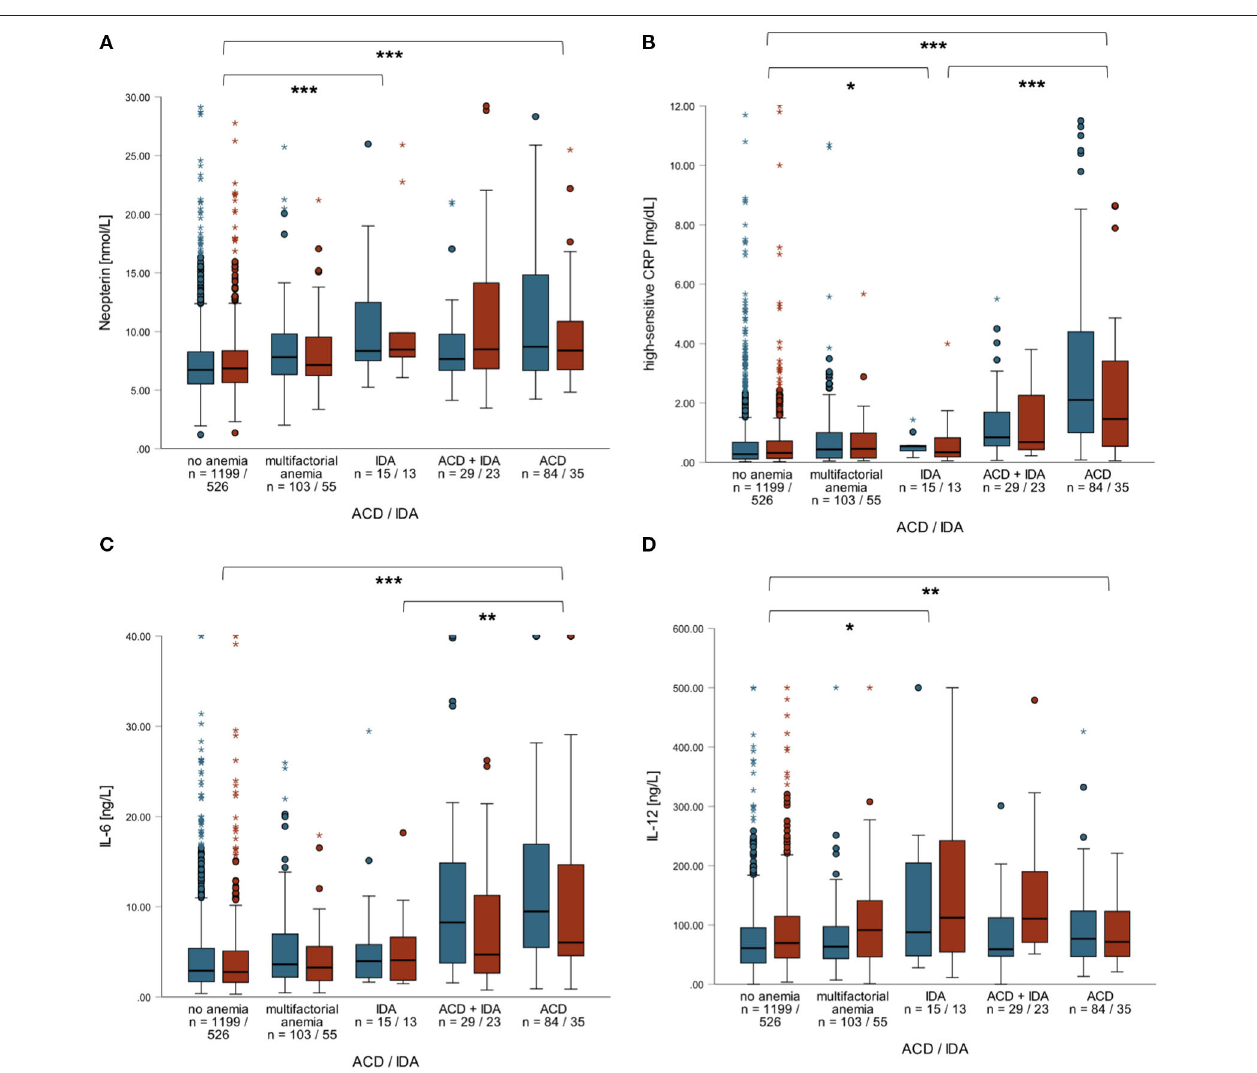
FIGURE 3 | Boxplots of neopterin (A) hsCRP (B) , IL-6 (C) and IL-12 levels (D) in men (blue) and women (red) with or without ACD and/or IDA or multifactorial anemia. Neopterin and IL-12 levels did not significantly differ between patients with ACD, ACD + IDA or IDA independent of sex. Contrary, IL-6 and hsCRP levels were significantly higher in patients with ACD compared to patients with IDA or ACD + IDA (especially in men). *** p < 0.001, ** p < 0.01, * p < 0.05.